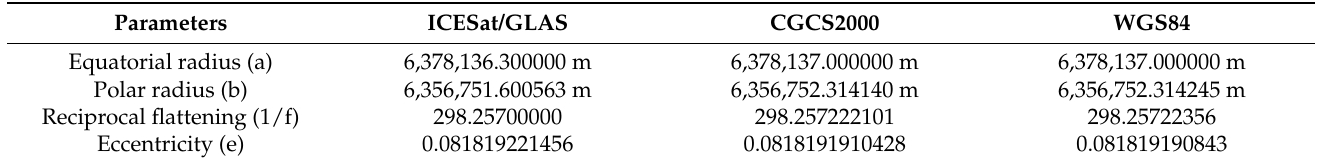
Table 2. The parameters for the reference ellipsoids of ICESat/GLAS, CGCS2000, and